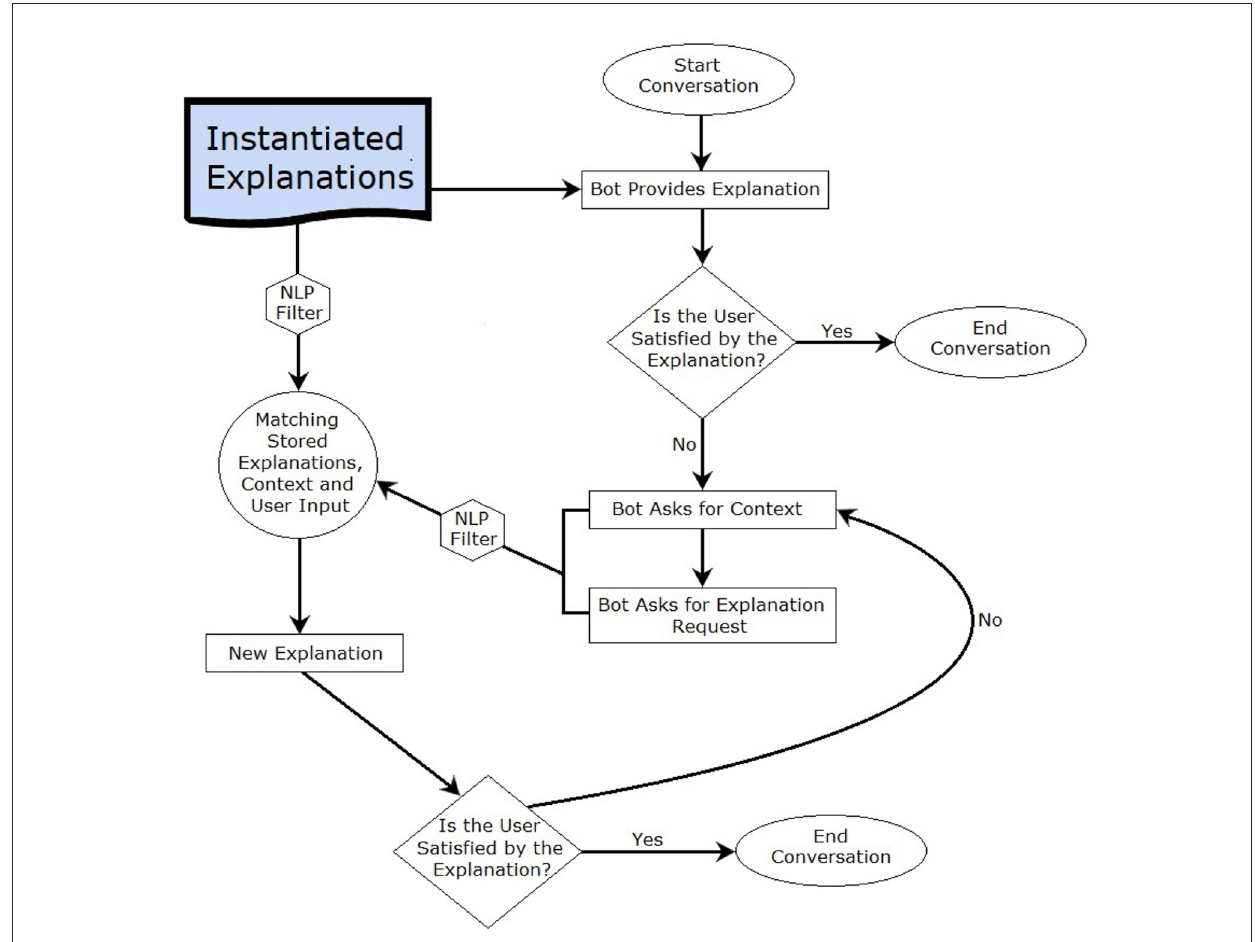
FIGURE2 Flow chart describing the high-level operations performed by the chatbot